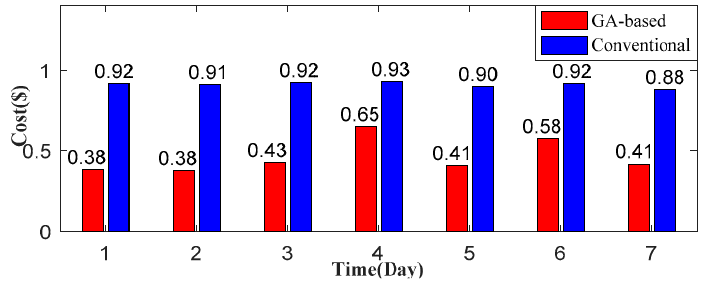
Figure 15. Comparison of daily cost between GA-based and conventional.